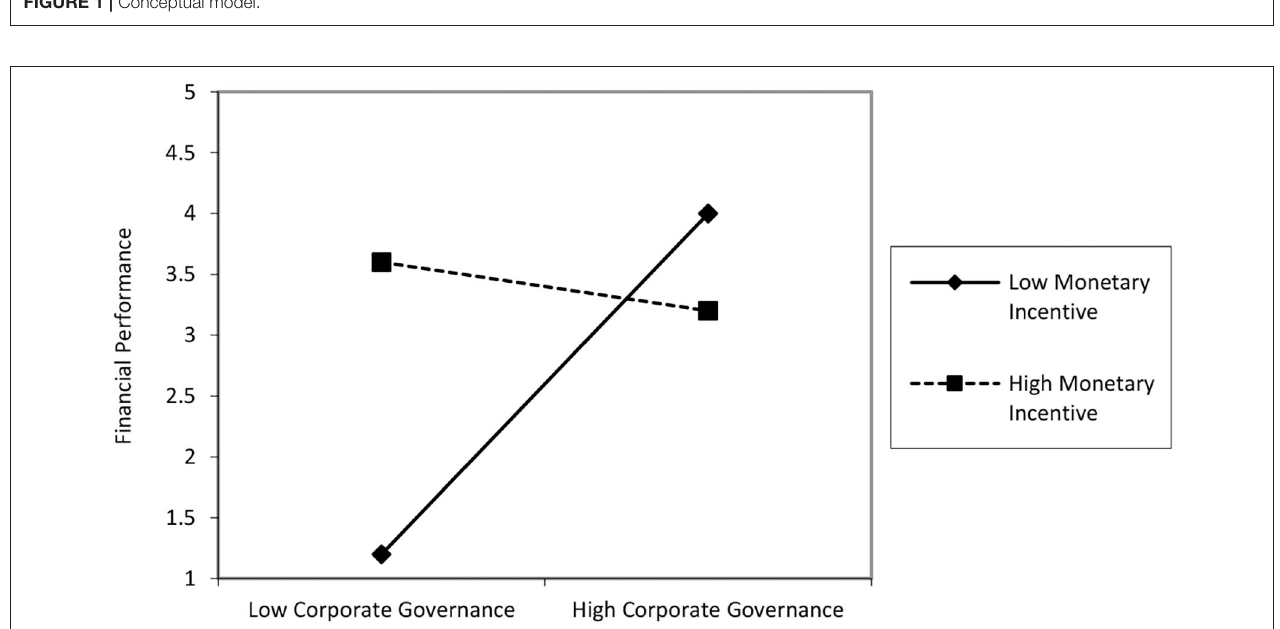
FIGURE 2 | Interaction